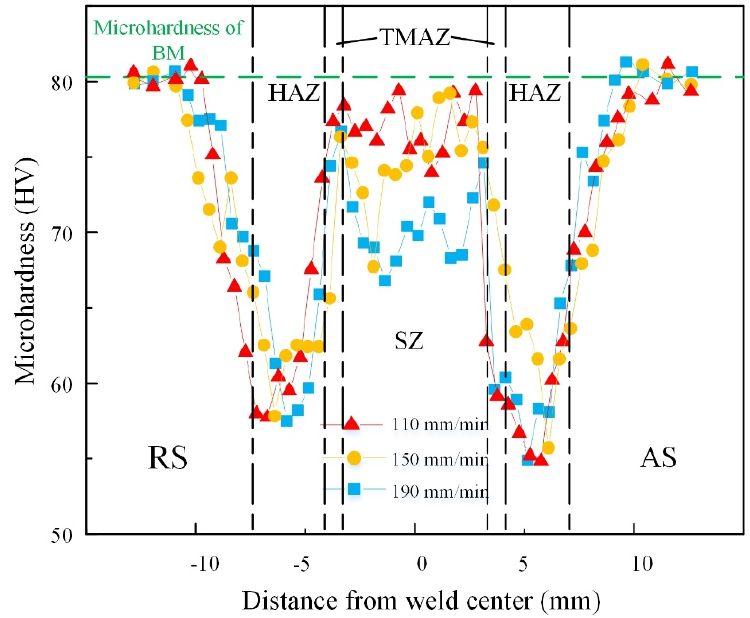
Figure 8. Microhardness distribution at different welding